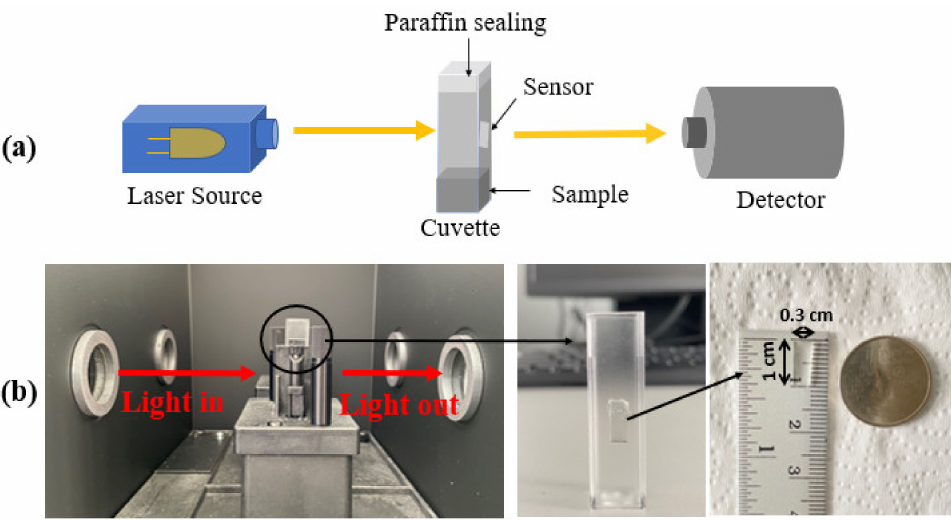
Figure 3. ( a ) Schematic diagram of the measurement used to analyze the sensing response of the sensor; ( b ) image of the actual setup and sensor